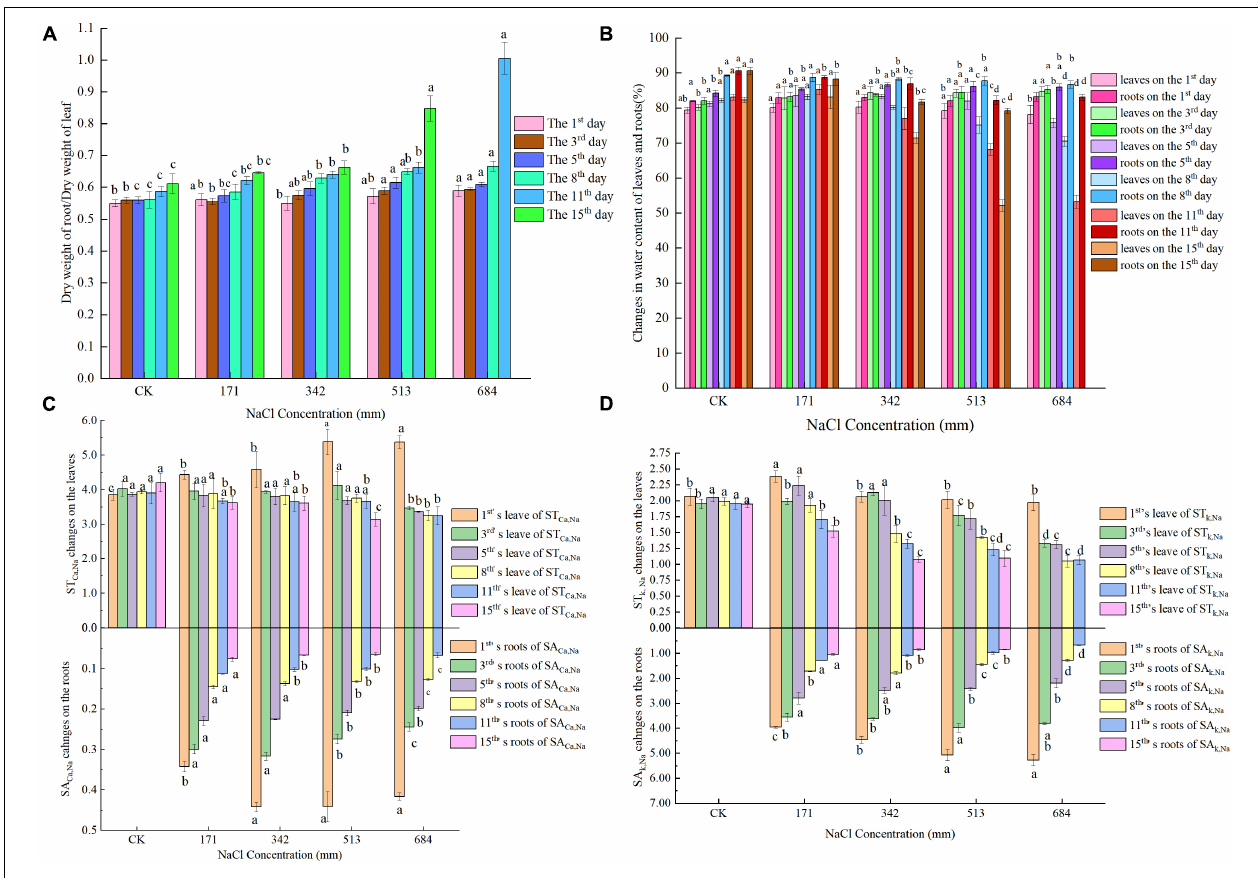
FIGURE 1 | Effects of salt stress on ratio of dry weight and water content of roots and leaves, ratio of selective absorption and transport of Na + / K + and Na + / Ca 2 + in roots and leaves; (A) effects of salt stress on ratio of roots and leaves dry weight of S. matsudana ; (B) effects of salt stress on water content of roots and leaves of S. matsulosa (C) effects of salt stress on selective uptake and transportation of Ca 2 + in roots and leaves of S. matsudana ; (D) effects of salt stress on selective uptake and transportation of K + in roots and leaves of S. matsudana . Data shown are means ± SEM. Different small letters indicate significant differences between treatments at 0.05 level among